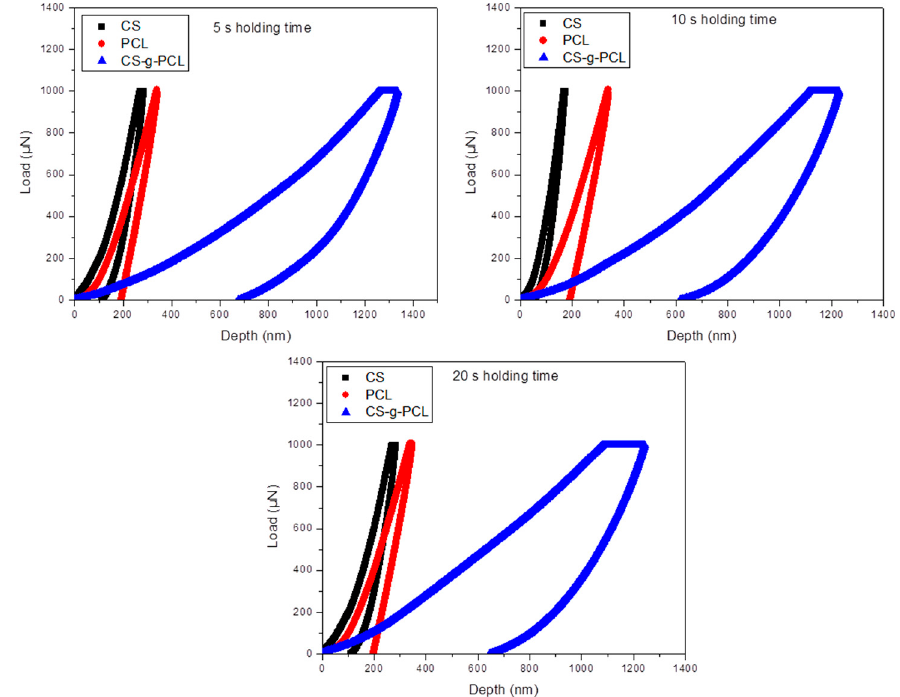
Figure 7. Load-unload curves at 1000 μ N maximum applied load with different holding times for the CS, PCL, and CS- g -PCL copolymer.